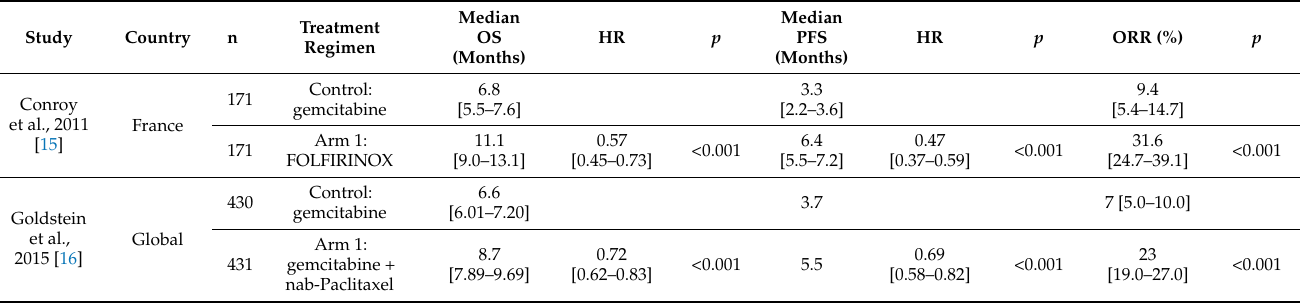
Table 2. Overall outcomes of included studies including OS, PFS, and ORR along with 95% confidence intervals where